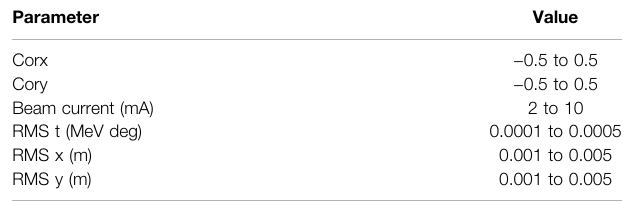
TABLE 3 | Input beam design variables to the fi xed FODO cell lattice generated using OPAL, and the range of their parameter space. Parameter